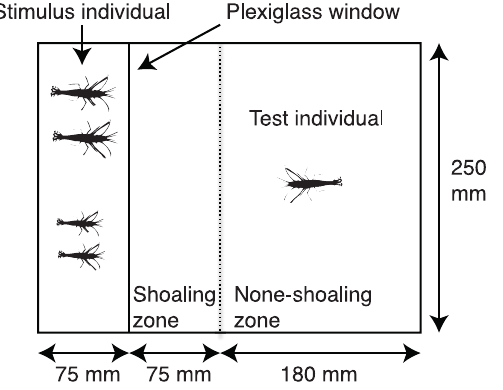
Figure 1. Experimental set-up for the shoaling behaviour trial.